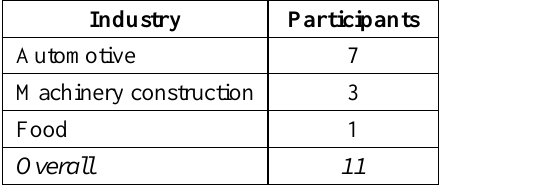
Table 2. Expert interviews (step 1): industry and competence distribution of participants (study